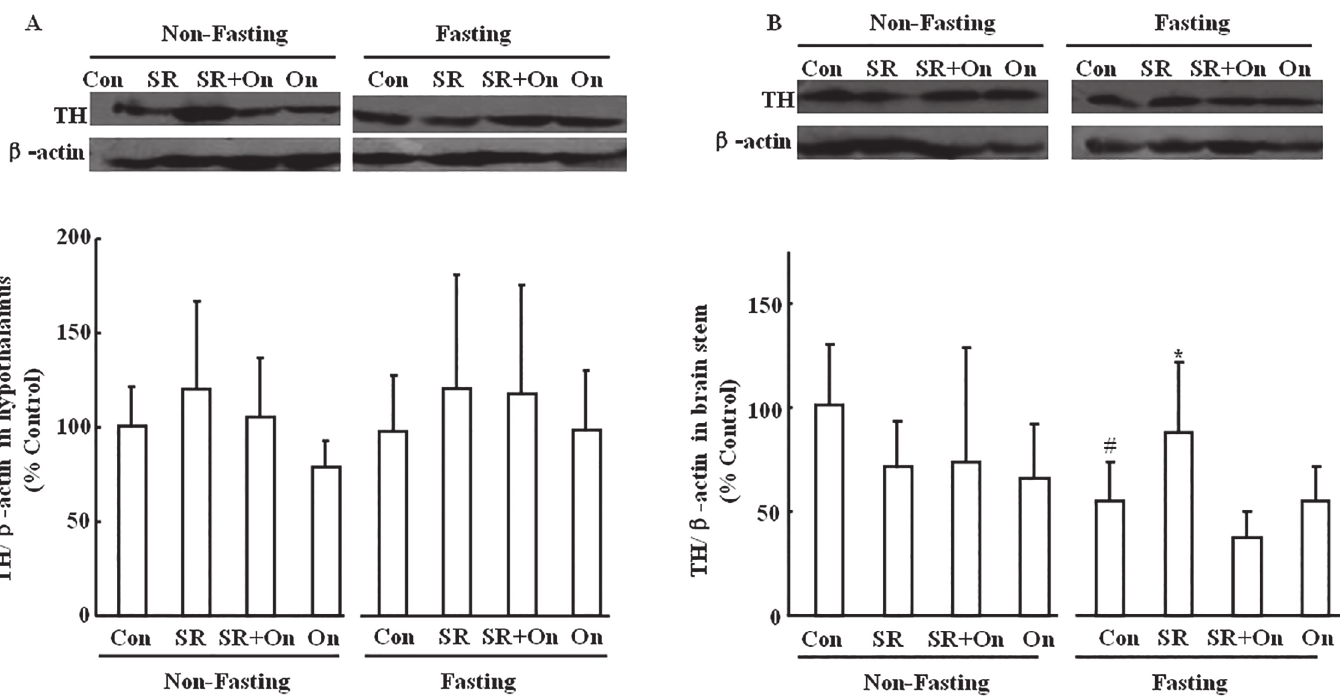
Fig 4. TH/ β -actin ratio,normalized to control, in hypothalamus and bran stem of fed and fasted mice. Con: control group; SR: SR 57227 (10 mg/kg, i. p.); On: ondansetron (3 mg/kg, i.p.). TH: tyrosine hydroxylase. Values are means ± SEM (n = 8 – 10). #, P < 0.05 vs. non-fasting control group; * , P < 0.05 vs. fasting control